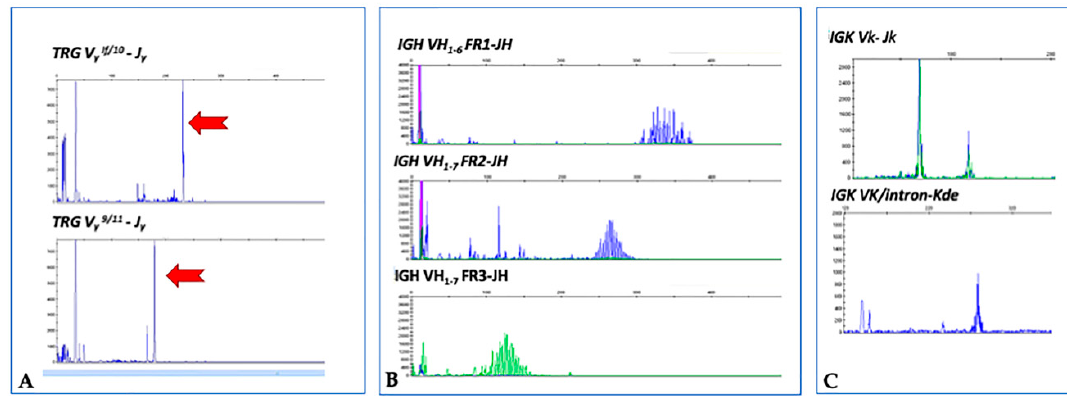
Figure 3. Gene scan analyses showing a clonal (red arrows) T-cell receptor gamma gene ( TRG ) ( A ) and polyclonal immunoglobulin heavy chain ( IGH ) ( B ) and light chain ( IGK ) ( C ) gene rearrangements.